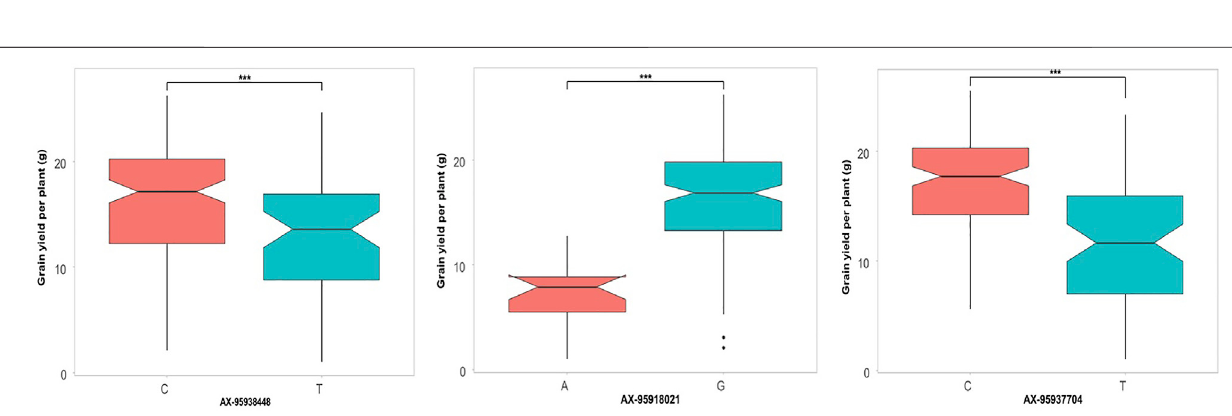
Frontiers in Genetics |